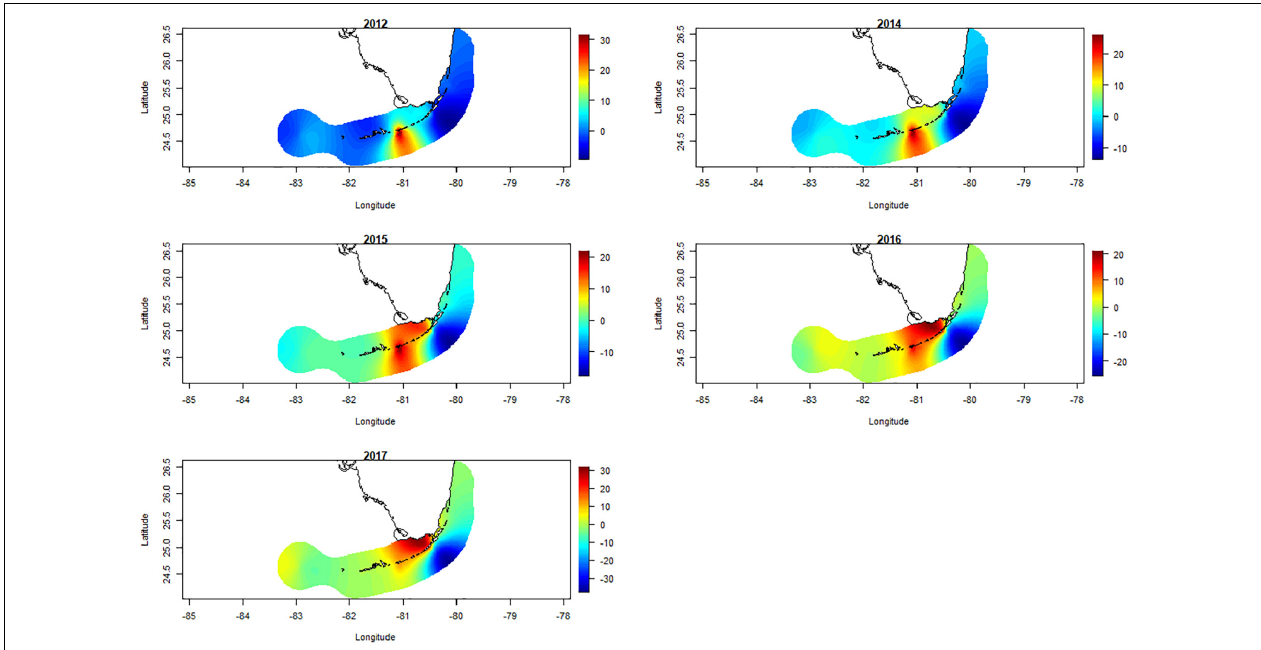
FIGURE 4 | Posteriori mean values of the spatial random effect for the years 2012, and 2014 to 2017 (note that 2013 and 2018 had insufficient data), obtained by the Integrated Nested Laplace Approximation (INLA) model, for 22,634 Acropora cervicornis outplants in 7 subregions along the Florida reef tract, United States—after considering “reef” and “subregion” as fixed effects. High survival of A. cervicornis outplants is highlighted in blue and low survival in